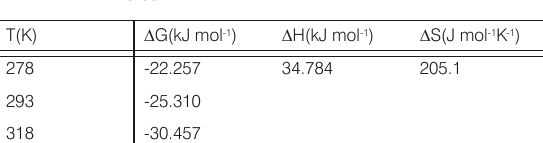
Table 3. The apparent thermodynamic constants of the sorption process of reactive dye Brilliant-Red HE-3B onto HPAN fibres.